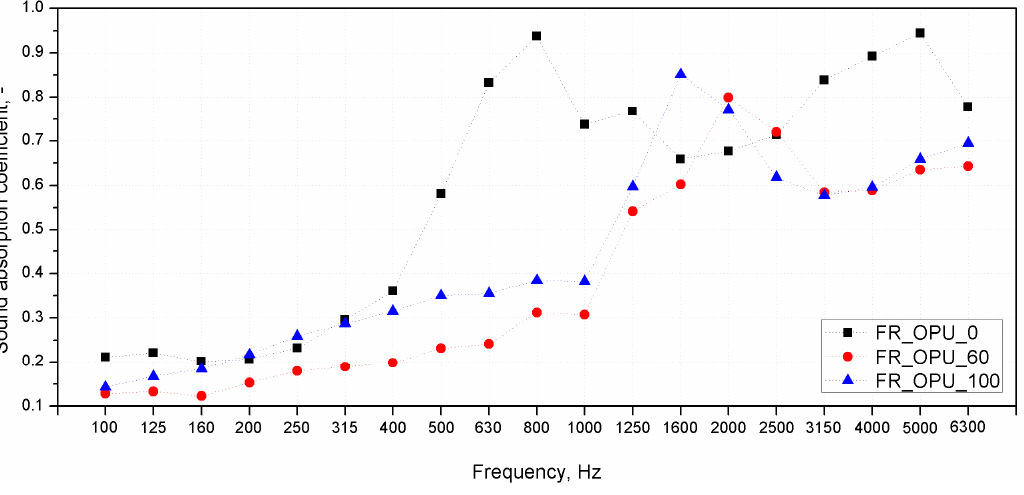
Figure 7. Sound absorption coefficients of FR_OPU PUR foams.